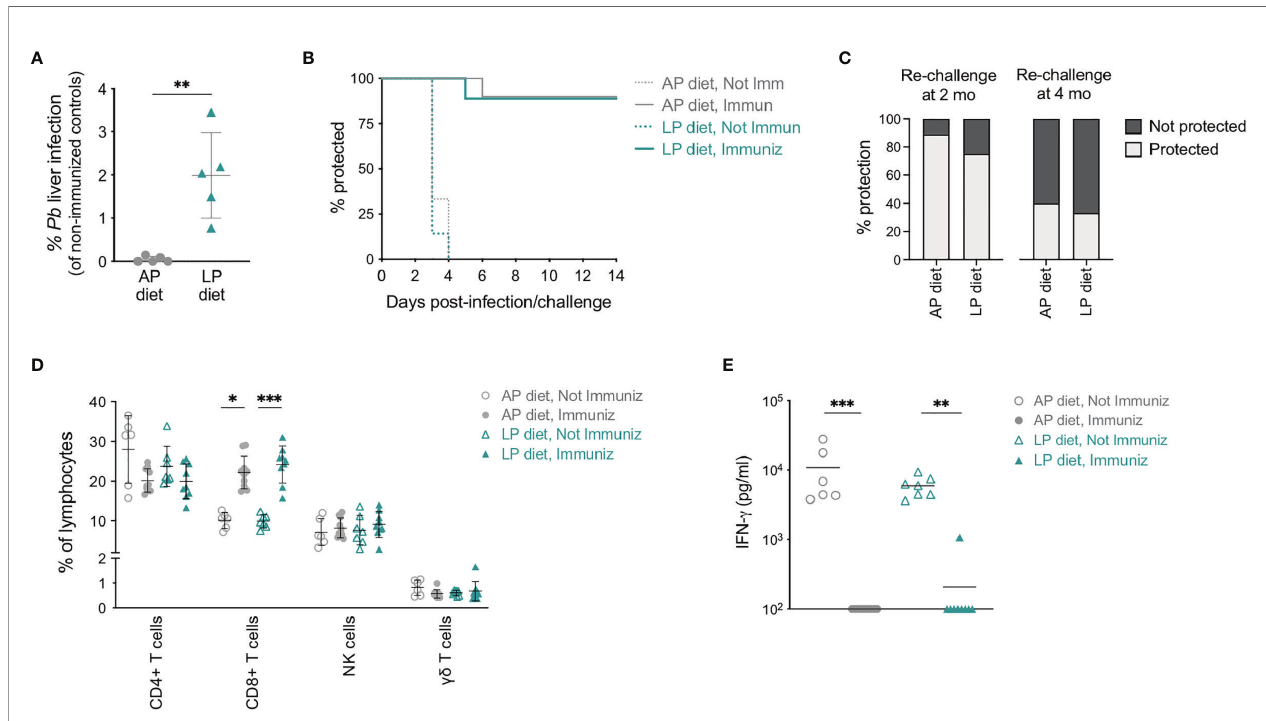
FIGURE 5 | Ef fi cacy of RAS immunization under low protein diet. (A) Relative parasite liver load (based on Pb 18S rRNA expression and compared to the corresponding non-immunized group) 48 h post-challenge of mice immunized under AP or LP diet. (B) Protection of non-immunized and RAS-immunized mice under AP or LP diet upon infection/challenge, as assessed by blood parasitemia (n = 6-10 mice per group). (C) Protection of RAS-immunized mice under AP or LP diet when re-challenged 2 or 4 months (mo) after the fi rst challenge. Mice without detectable blood parasitemia until day 14 were considered protected (n = 3-9 mice per group). (D) Frequency of CD4+ T, CD8+ T, gd T and NK cells in the peripheral blood of non-immunized or RAS-immunized mice under AP or LP diet, 5 days after infection/challenge. (E) Levels of IFN- g in the plasma of non-immunized or RAS-immunized mice under AP or LP diet, 5 days after infection/challenge. Data are presented as mean ± SD and were compared using the Mann-Whitney test (two-sample data), or the Kruskal-Wallis test with Dunn ’ s multiple comparison post-test with selection of the following pairs: AP diet Not Immunized (NImm) vs. AP diet Immuniz (Imm), LP diet NImm vs. LP diet Imm, AP diet NImm vs. LP diet NImm and AP diet Imm vs. LP diet Imm (*P < 0,05; **P < 0,01; ***P <